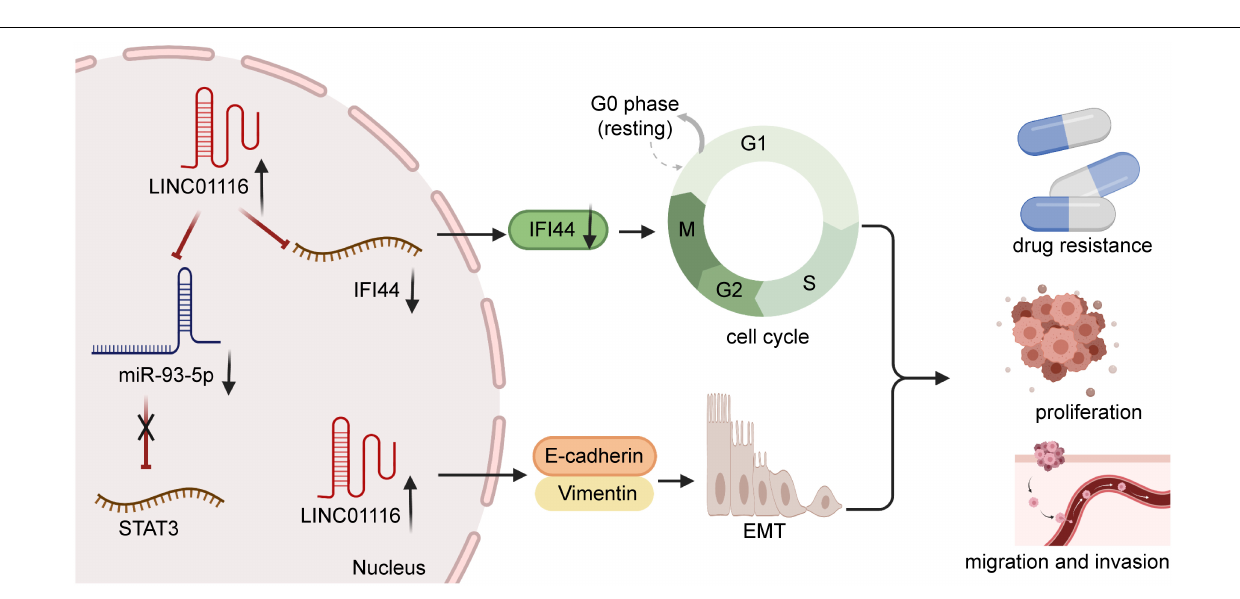
(KIRP), testicular germ cell tumor (TGCT), and uterine corpus endometrial carcinoma (UCEC) ( Figure 1A